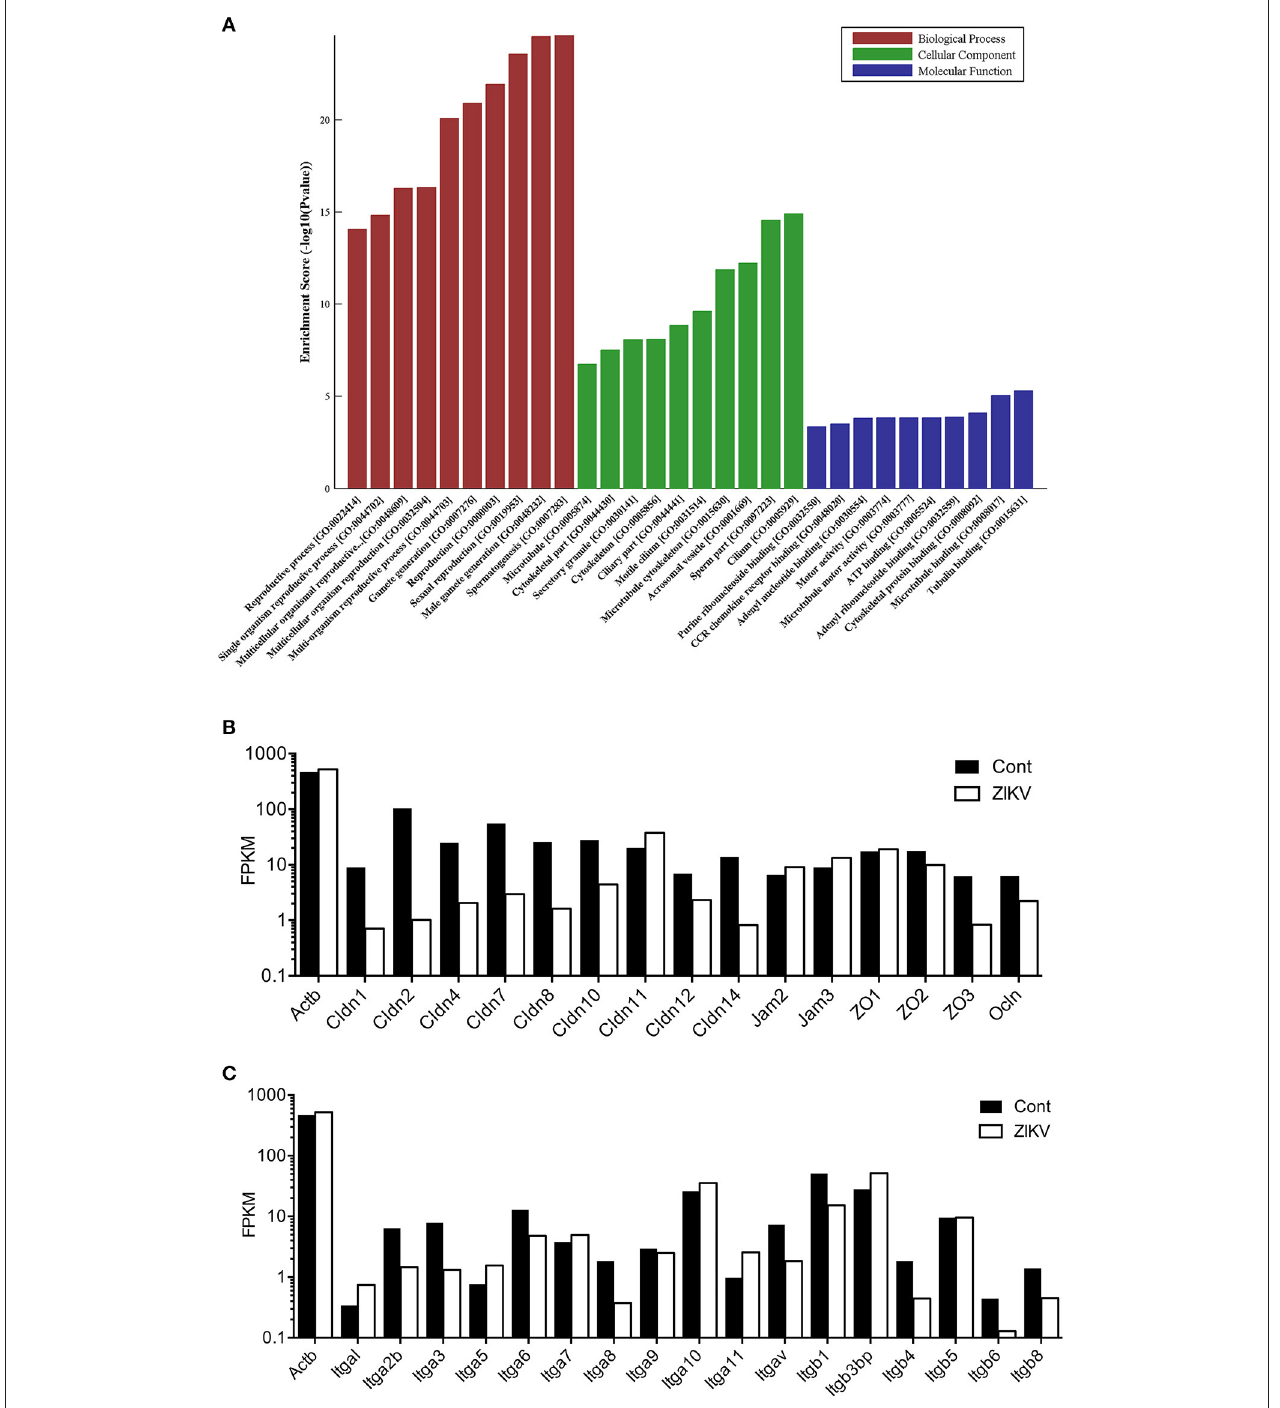
FIGURE 4 | Transcriptome analysis for various pathways in mouse testes at 5dpi after ZIKV-infection. (A) Gene ontology (GO) analysis for gene upregulated in testes of ZIKV-infected mice at 5 dpi ( n = 3). Uninfected mouse testes serve as control ( n = 3). The ontology covers three domains: Biological Process (red), Cellular Component (green) and Molecular Function (blue). Fisher’s exact test is used for the GO analysis ( p < 0.05). (B,C) Transcriptome analysis of selected genes associated with tight junction pathway (B) and integrins (C) in ZIKV-infected testes at 5 dpi. The results were expressed as Fragments Per Kilobase Million (FPKM). Beta-actin (Actb) was used as